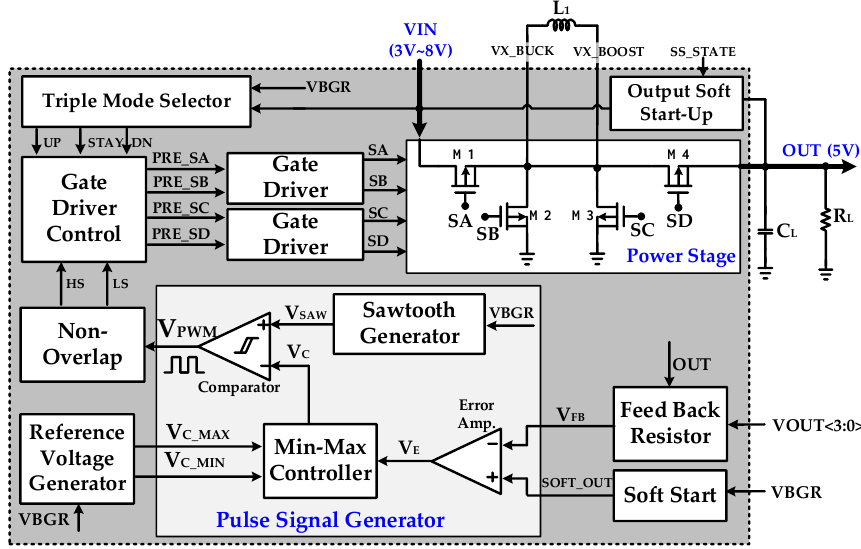
Figure 1. The proposed buck-boost DC–DC converter.